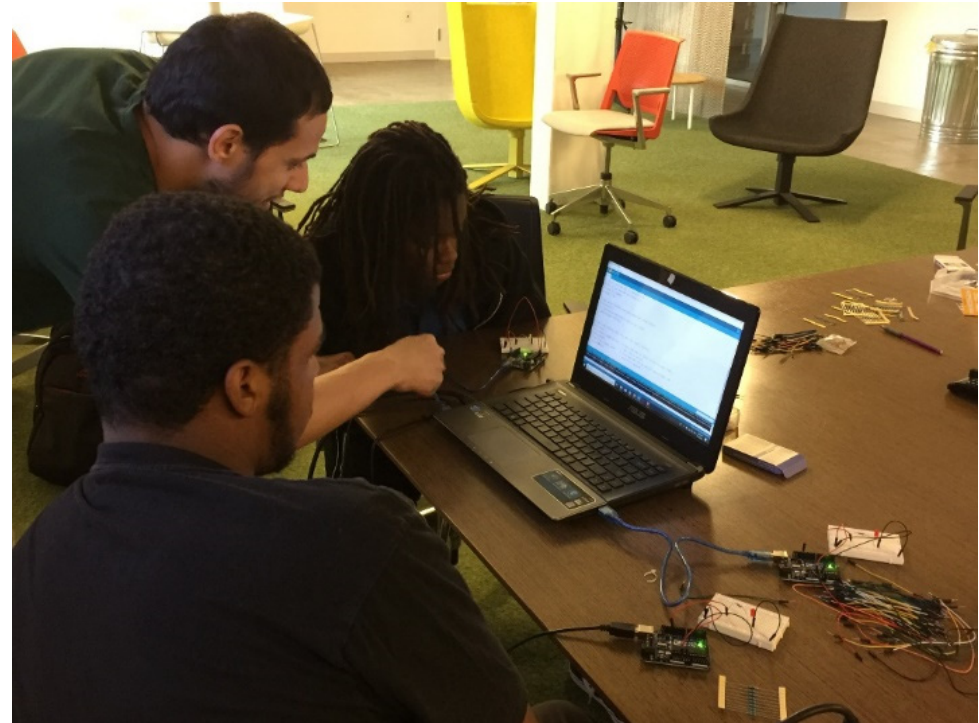
Figure 4. Middle and high school students working with architecture students on coding.